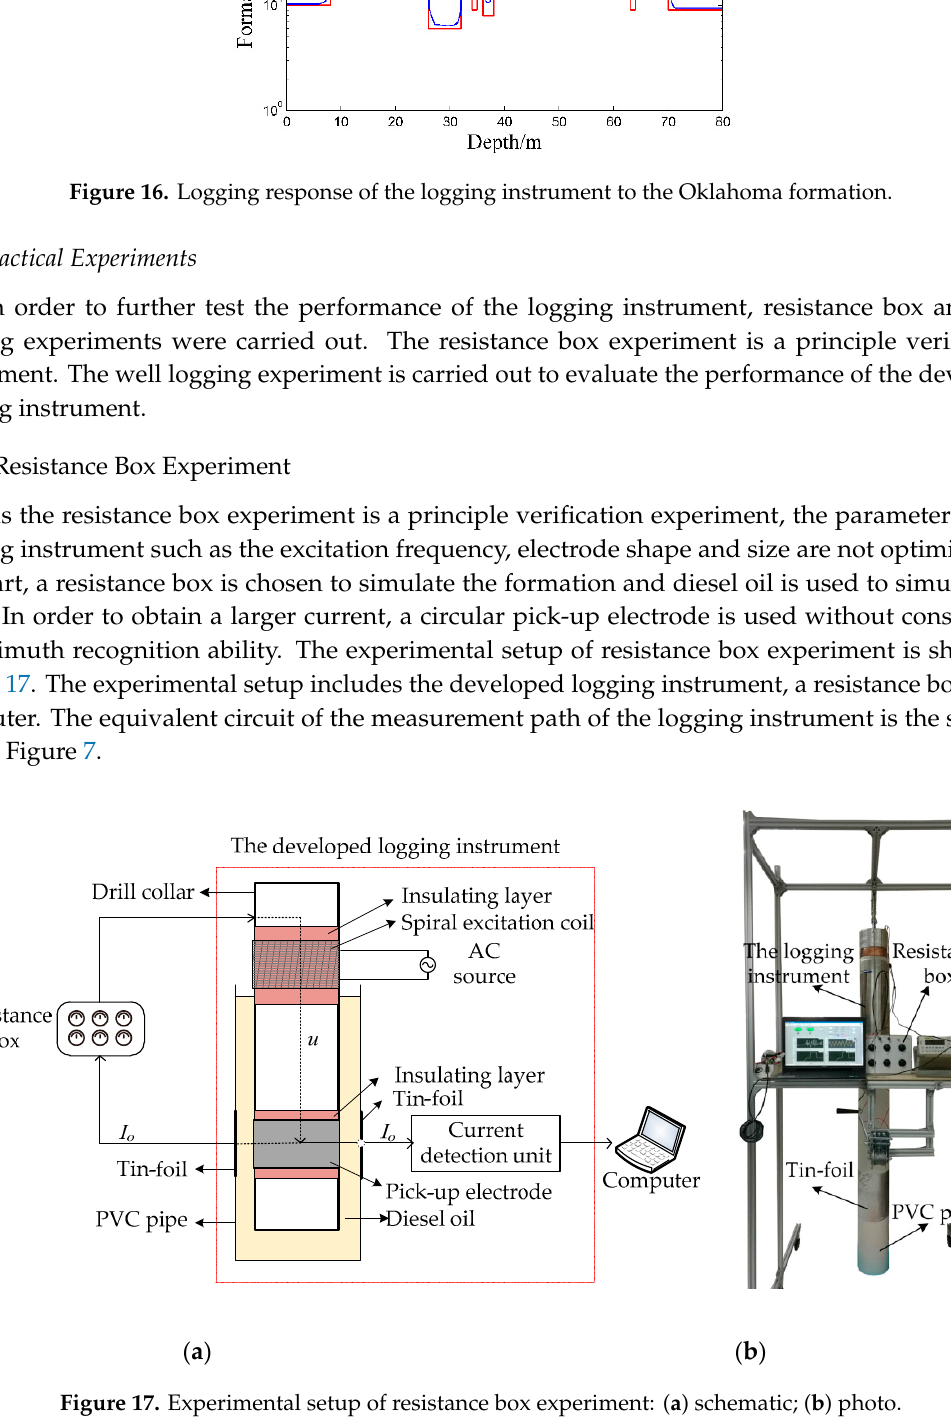
( b ) Figure 18. Results of resistance box experiment: ( a ) measured resistance; ( b ) relative errors. Figure 18 shows the results of the resistance box experiment. As is shown in Figure 18, the relative errors σ r of the resistance measurement by the developed instrument are less than ± 1.67%. This result indicates that the logging instrument has good resistance measurement accuracy. 3.2.2. Well Logging Experiment Considering the real logging conditions, an experimental well is built to simulate the real formation. The experimental well is composed of sandstone, which is one of the common rocks in the real formation. The sandstones are provided by the Huiyu stone company, Hangzhou, China and the origin of the sandstones is Chengdu, China. The resistivity of the sandstones is about 4000 Ω ·m. There